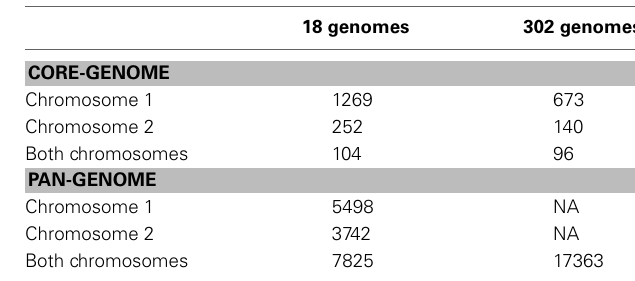
Table 2 | List of species analyzed in this